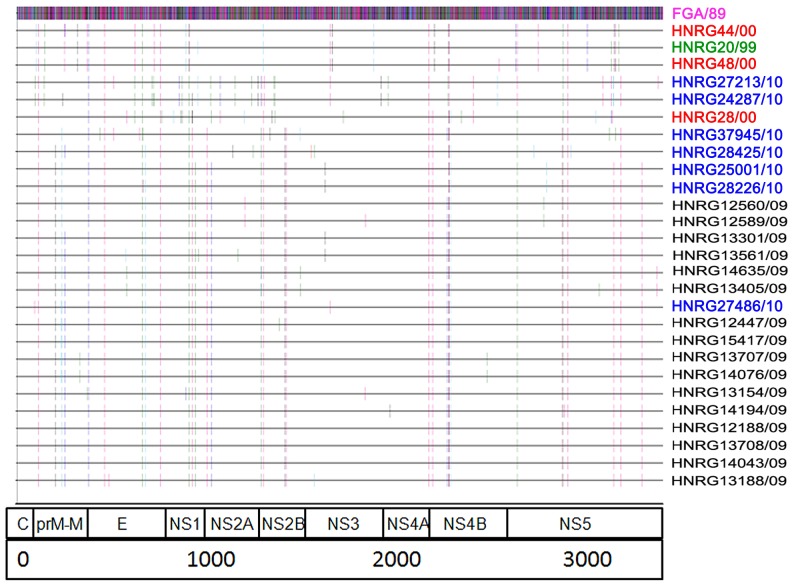
Location of non-synonymous changes in the polyprotein of DENV-1 strains in relation to the reference sequence FGA/89.Polar and non-polar amino acids are coded as follows: hydrophobic in pink (Ala, Phe, Ile, Leu, Met, Pro, Val, Trp); polar but uncharged in light blue (Cys, Gly, Asn, Gln, Ser, Thr, Tyr); negatively charged in gray (Asp, Glu); and positively charged in red (His, Lys, Arg).